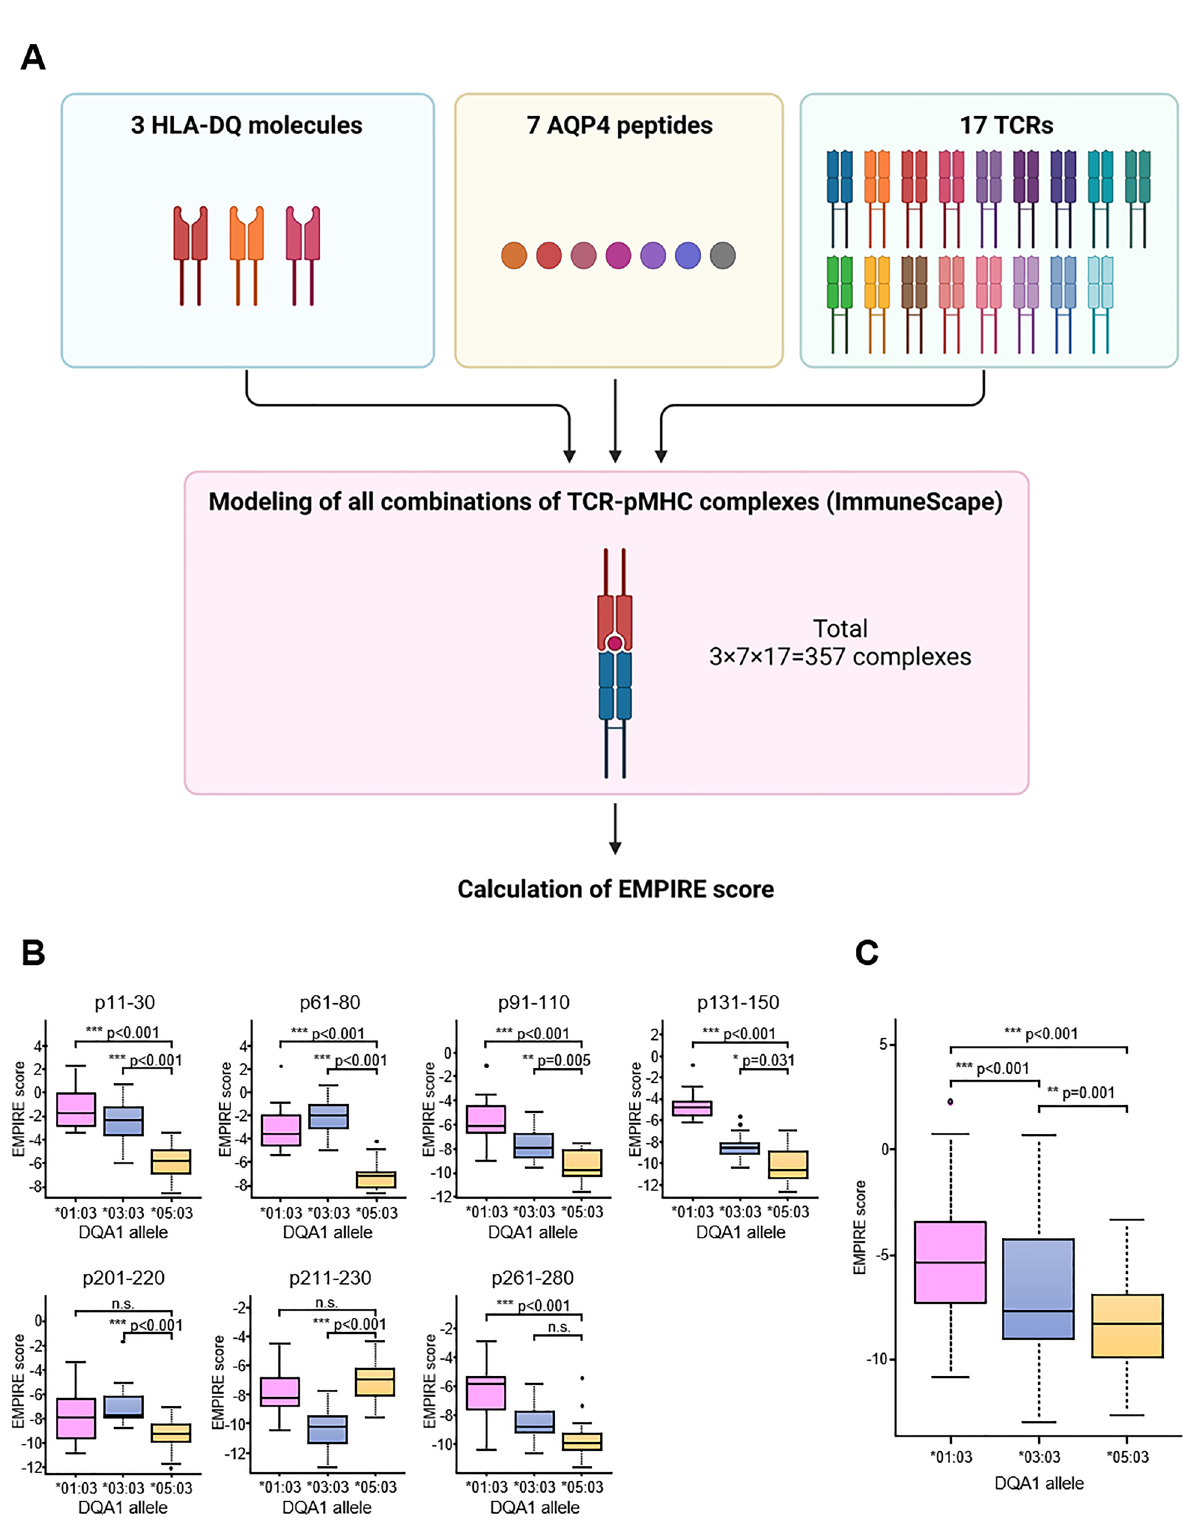
Figure 4. The energetic stability of pMHC complex. ( A ) Procedure for modeling and calculation of EMPIRE score using ImmuneScape. This schema was created with BioRender.com. ( B , C ) Comparison of energetic pMHC complex stability between three HLA-DQA1 alleles binding. ( B ) EMPIRE score with each immunodominant AQP4 peptide. ( C ) Average EMPIRE score with all seven immunodominant AQP4